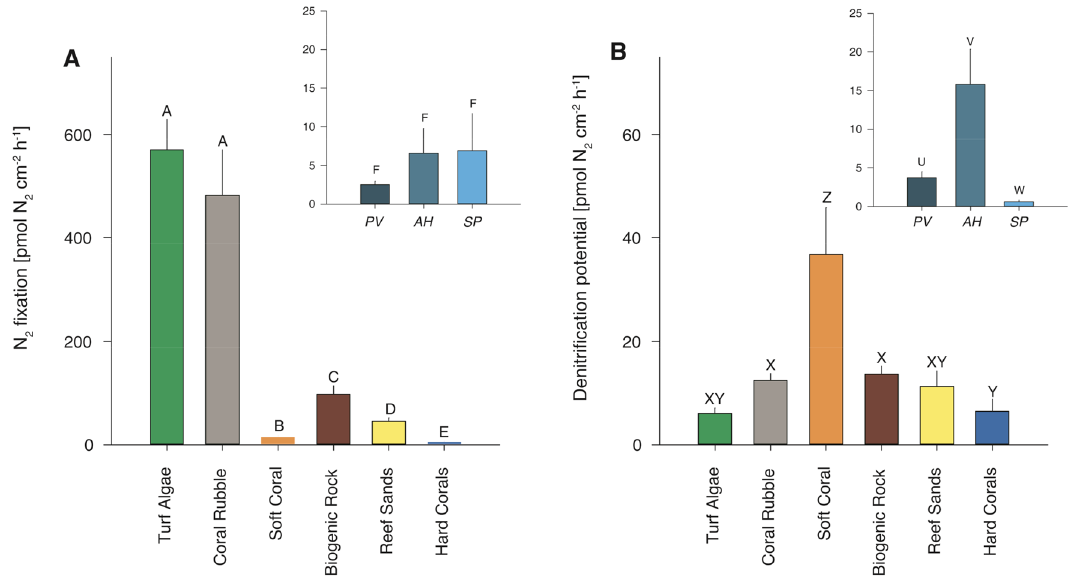
Figure 2. (A) Dinitrogen (N 2 ) fixation rates and (B) denitrification potential of investigated benthic categories and hard coral species. Organisms and substrates (turf algae n = 5, coral rubble n = 4, soft coral n = 5, biogenic rock n = 5, reef sands n = 5, hard corals n = 13) were sampled randomly from both reef areas. Rates and potential for hard corals consist of mean values of P. verrucosa (PV, n = 5), A. hemprichii (AH, n = 4), S. pistillata (SP, n = 4). Letters above bars indicate significant differences if different, or non-significance if shared. Y-Axis labels for imbedded hard coral data plots are analogue to respective N 2 fixation rate or denitrification potential plot. Note different scales for N 2 fixation and denitrification.